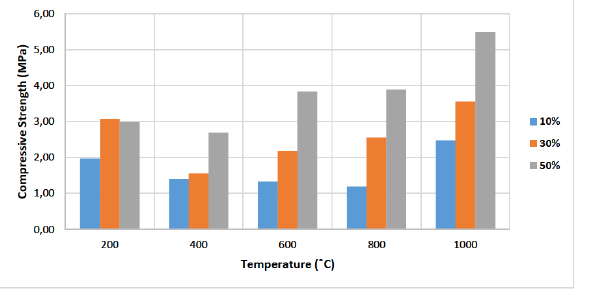
Figure 14: Change of compressive strength of geopolymer foams vs. heating temperatures.